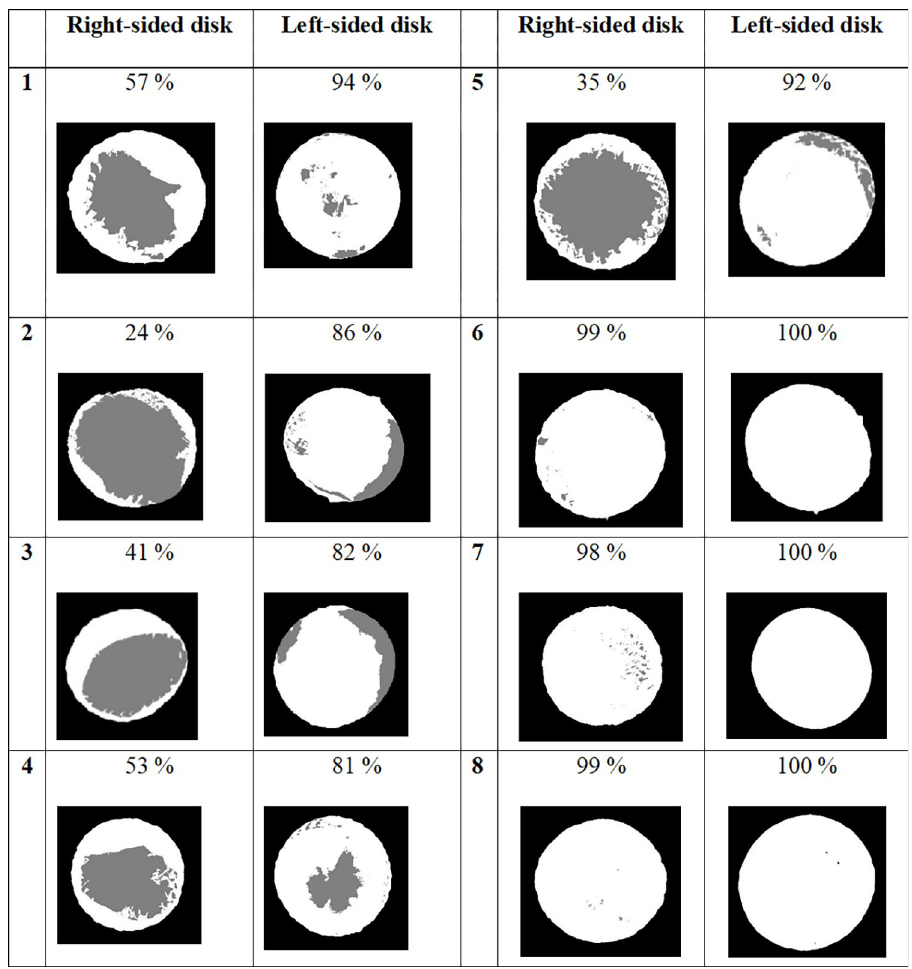
Fig 8. Surface coverage of the disks of the eight devices. Devices 1–3 explanted after one-month follow-up. Devices 4–8 explanted after 3-month follow-up. The surface of the disk which is covered with tissue appears in